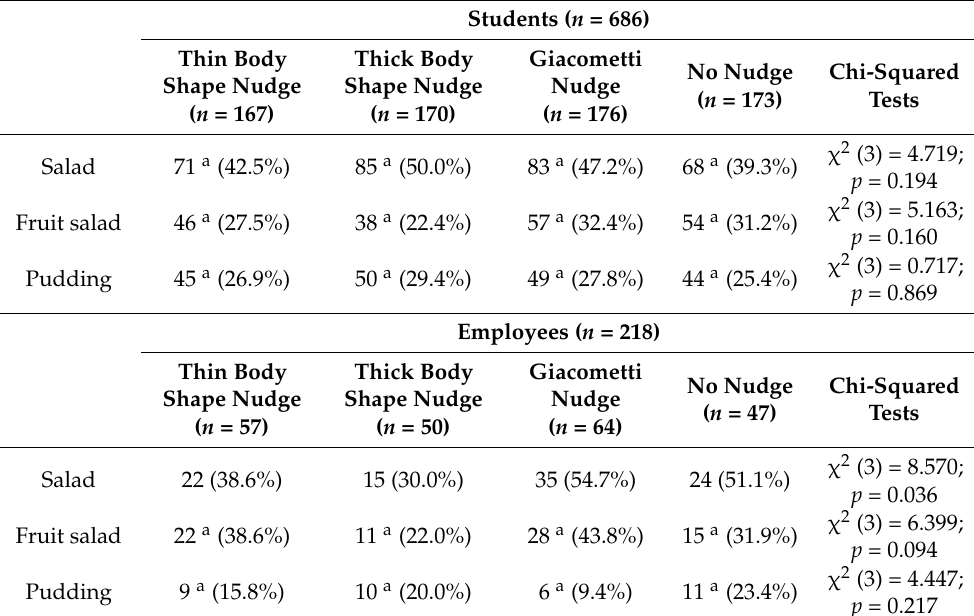
Table 2. Frequencies of the dishes ordered and inferential analyses for the students and employees.